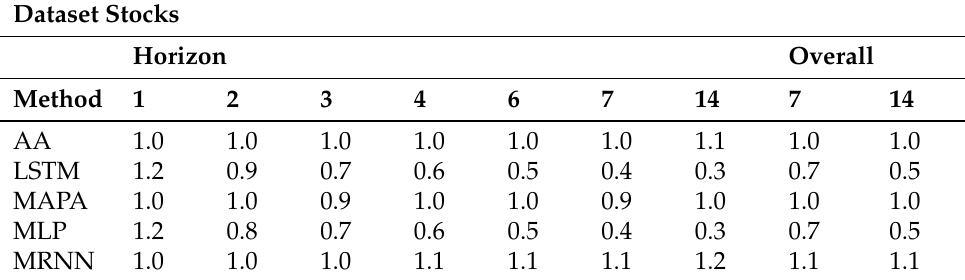
Table 2. Average MASE of multi-step forecasts from Prophet, MAPA, the two multiresolution forecasting methods, MRR using regression and MRNN using a neural network, seasonal adapted ARIMA (SA), automatized ARIMA (AA), multilayer perceptron (MLP), long short-term memory (LSTM) and gradient boosting machine (XGB) for different horizons and for the mean over horizons from 1 to 7 and 1 to